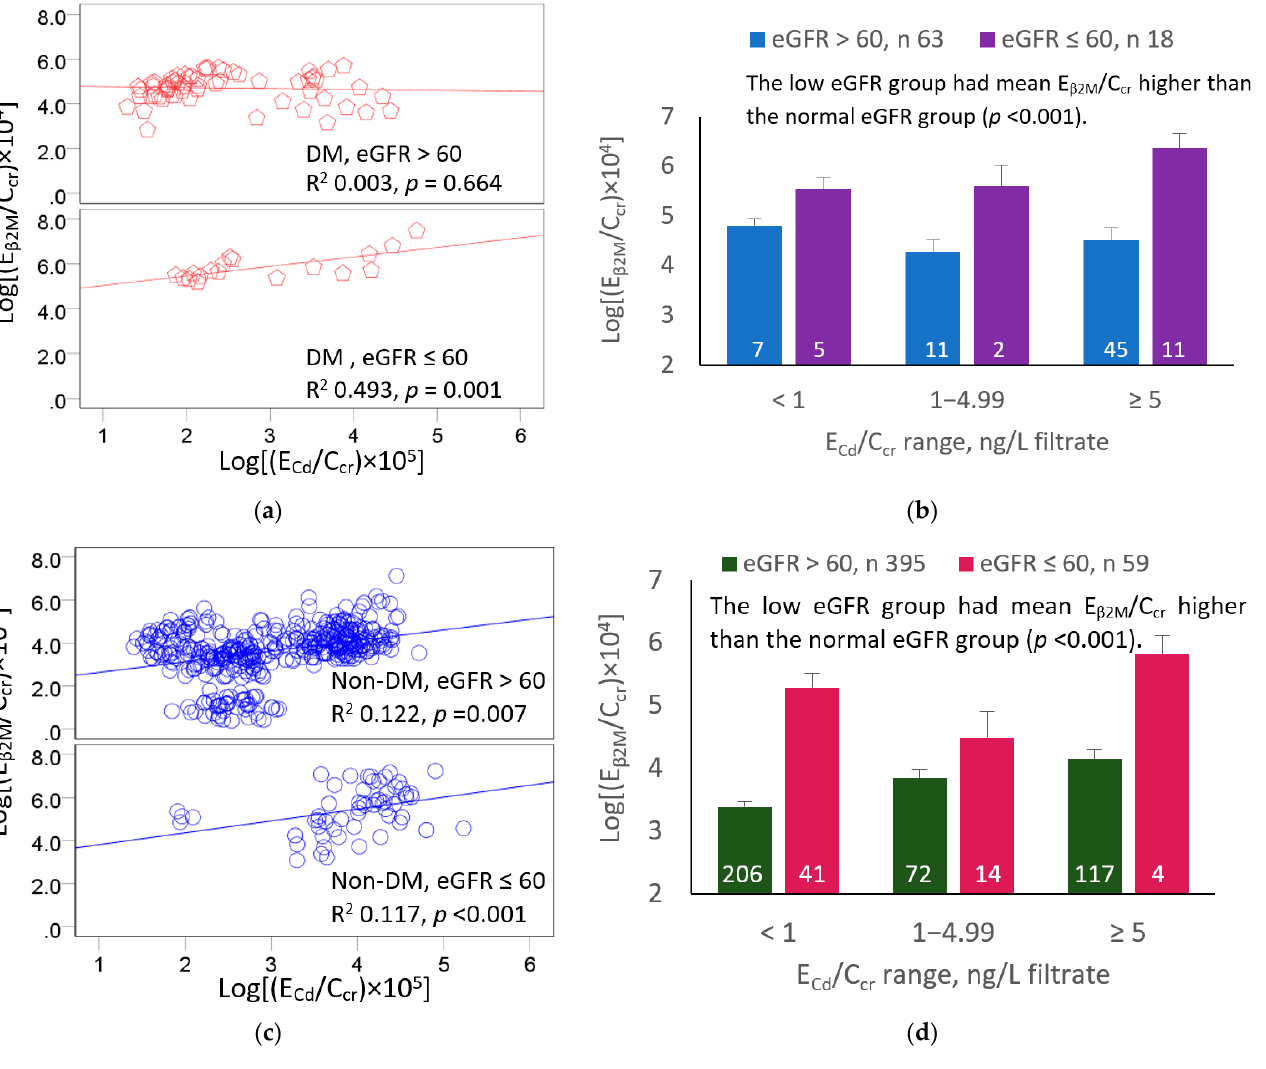
Figure 3. Increments of β 2 M excretion as a function of kidney cadmium burden and GFR. Sca tt erplot ( a ) relates log[(E β 2M /C cr ) × 10 4 ] to log[(E Cd /C cr ) × 10 5 ] in diabetics grouped by eGFR levels > 60 and ≤ 60 mL/min/1.73 m 2 . Bar graph ( b ) depicts mean log[(E β 2M /C cr ) × 10 4 ] in diabetics grouped by eGFR and ranges of E Cd /C cr . Sca tt erplot ( c ) relates log[(E β 2M /C cr ) × 10 4 ] to log[(E Cd /C cr ) × 10 5 ] in non-diabetics grouped by eGFR levels > 60 and ≤ 60 mL/min/1.73 m 2 . Graph ( d ) depicts mean log[(E β 2M /C cr ) × 10 4 ] in non-diabetics grouped by eGFR and ranges of E Cd /C cr . Coe ffi cients of determination (R 2 ) and p - values are provided for all sca tt erplots. Mean values were adjusted for age and BMI di ff erences, and interactions. Units of E β 2M /C cr and E Cd /C cr are ng/L of fi ltrate, and the unit of eGFR is mL/min/1.73 m 2 .